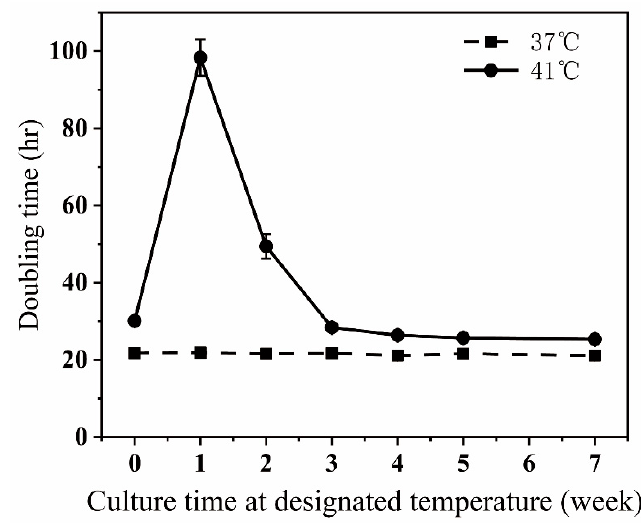
Figure 1. The doubling times of the cells incubated at 37 °C and at 41 °C. Cells were incubated at either 37 °C or at 41 °C continuously for 7 weeks. At the beginning of every week, a portion of cells were removed from the main cultures and seeded for the doubling time measurement. Refer to Materials and methods for the experiment procedure and calculation of the doubling times. The results were derived from three independent repetitive experiments.